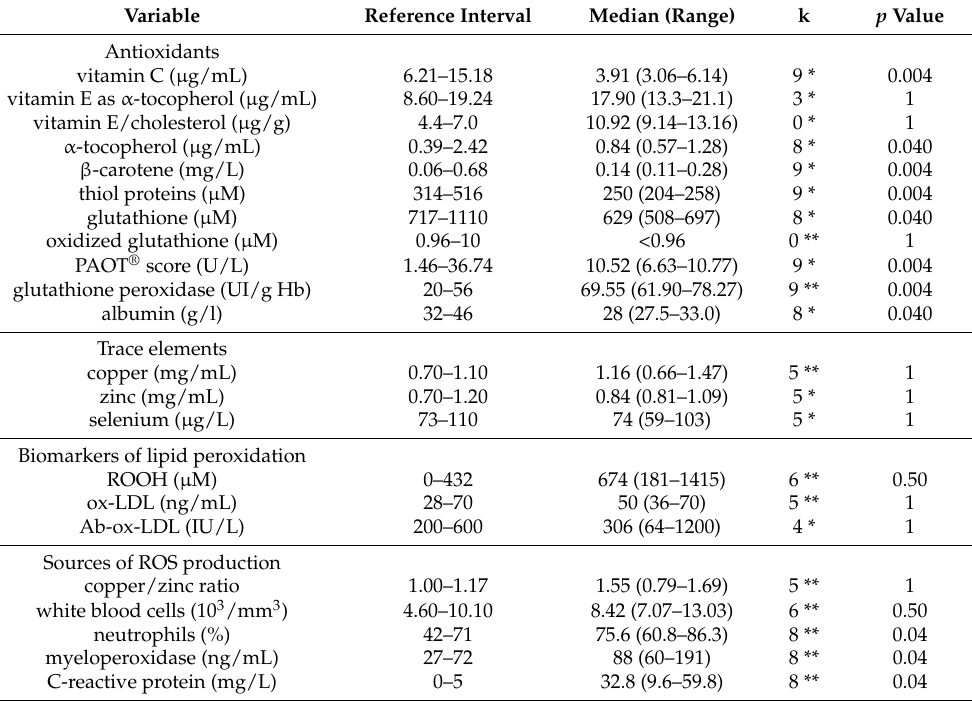
Table 4. Statistical comparison of OS biomarkers in all COVID-19 patients (N = 9) with their reference interval using the sign test based on the binomial distribution (see statistical analysis). k: number of COVID-19 values below * or above ** the middle of reference